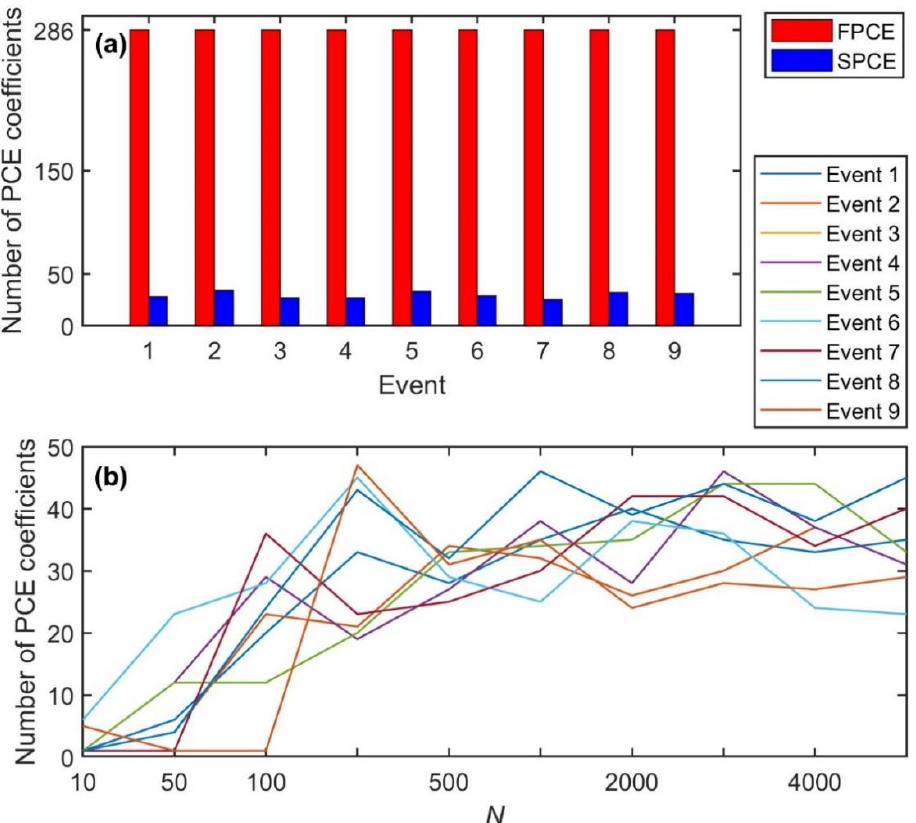
Figure 4. ( a ) The number of nonzero PCE coefficients in constructing FPCE (with 𝑁 of 2000) and SPCE (with 𝑁 of 500) for nine streamflow events. ( b ) The effects of N on the number of PCE coefficients in SPCE for nine events.